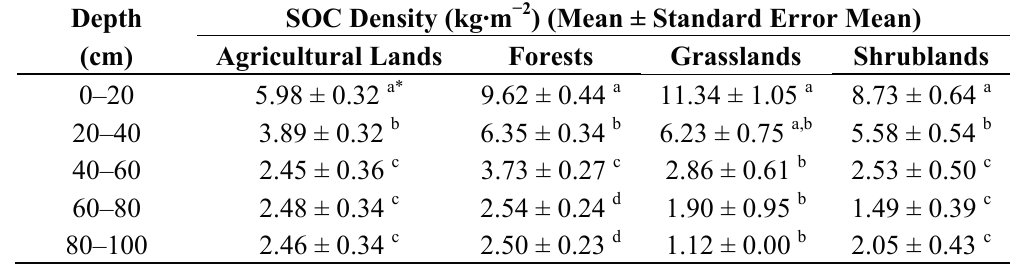
Table 5. Vertical distribution of mean SOC density values under different LULC